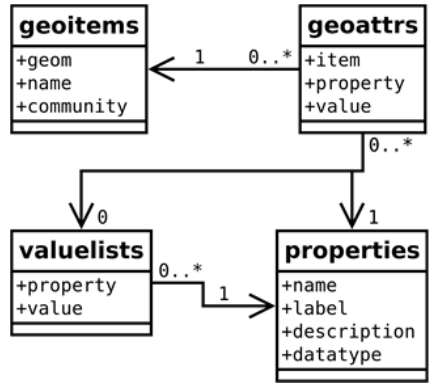
Figure 1 : Simplified table structure of the generic